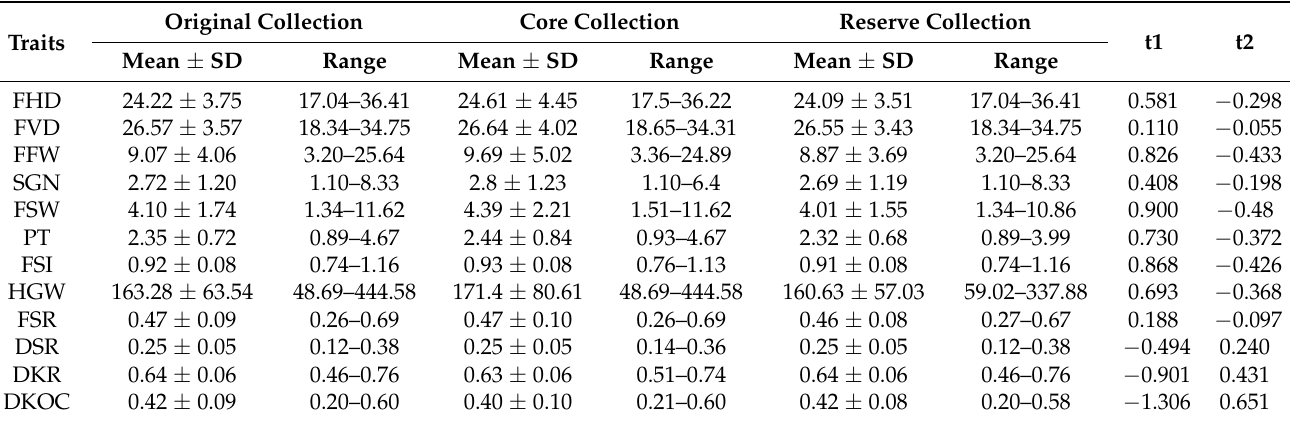
Table 8. Comparison of character parameters between the original, reserved, and core collections.